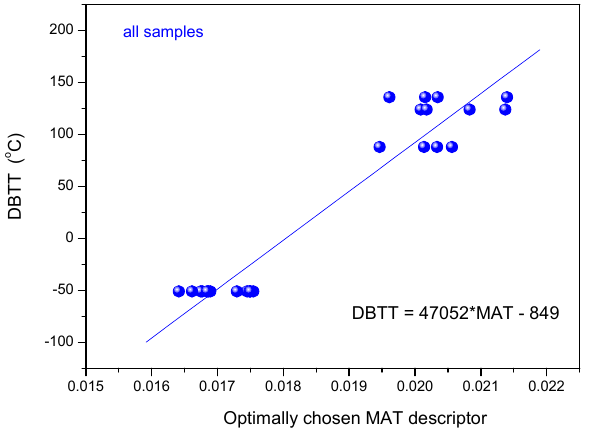
Figure 7. Estimation of the transition temperature from the MAT descriptors, measured on all investigated samples. The DBTT values are taken from the Charpy impact tests.